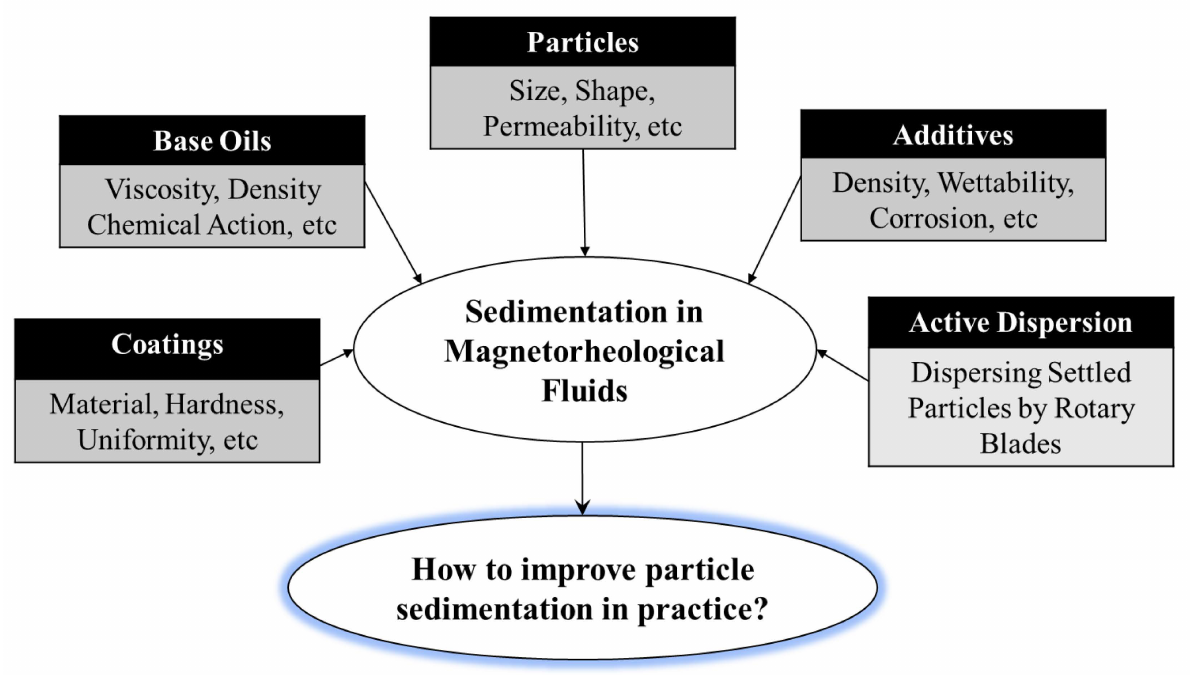
Figure 1. Various recipes to improve the sedimentation stability of